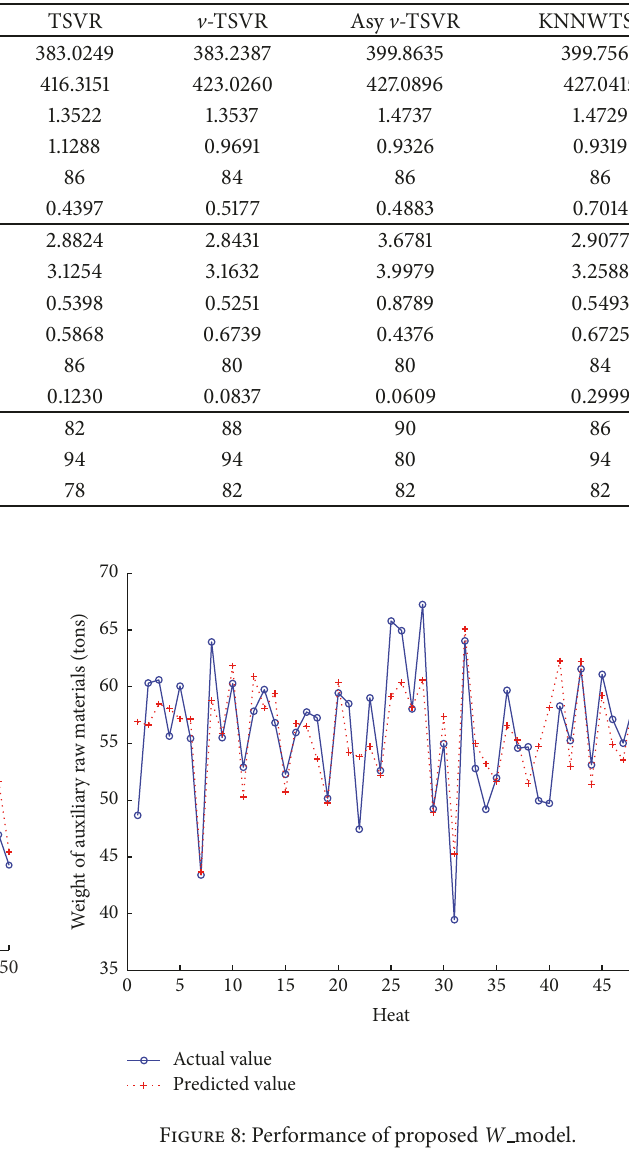
Table 8: Performance comparisons of V / W control models with four methods.